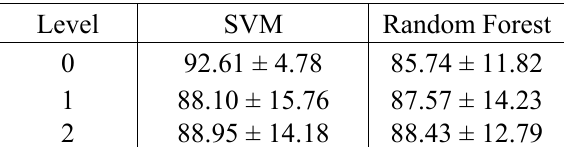
Table 5. Comparison of SVM and random forest as categorization methods using as input reduced feature vectors with uniform measurement threshold θ = 4 . R esults are shown in